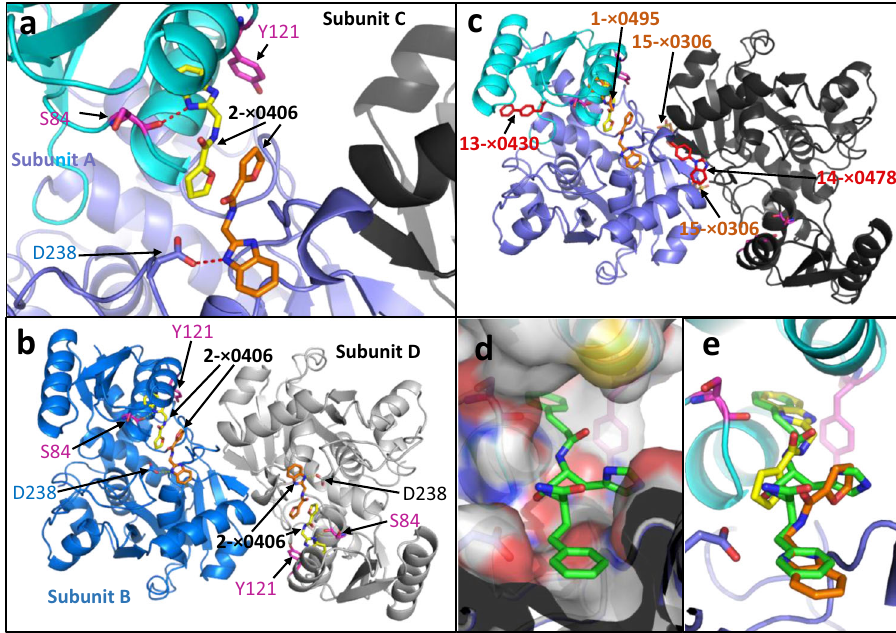
Fig. 7 XChem compound 2-x0406 has two adjacent binding sites. a The A subunit from the AC dimer in the 1.77 Å crystal structure of hSR with 2-x0406 (pdb code: 7NBH) contains two compounds. The compounds donate hydrogen bonds (dotted red-lines) to the main chain carboxyl of Ser 84 or to the side- chain of Asp 238. b The BD dimer with similar orientation as ( a ). Two molecules of compound 2-x0406 are also bound to the B and D subunits. c Superposition on the AC dimer of 2-x0406 (7NBH) of four other XChem compounds (sticks, labelled) from 7NBD, 7NBF, 7NBG, and 7NBC (C-subunit superposed on A). Note the C-subunit has no 2-x0406 or 1-x0495 bound. d, e Compound 9 (green carbons) from Dixon et al. (2006) 46 has been docked into the electron density corresponding to two adjacent molecules of compound 2-x0406 (yellow and orange carbons). Table 1 Primer sequences used for